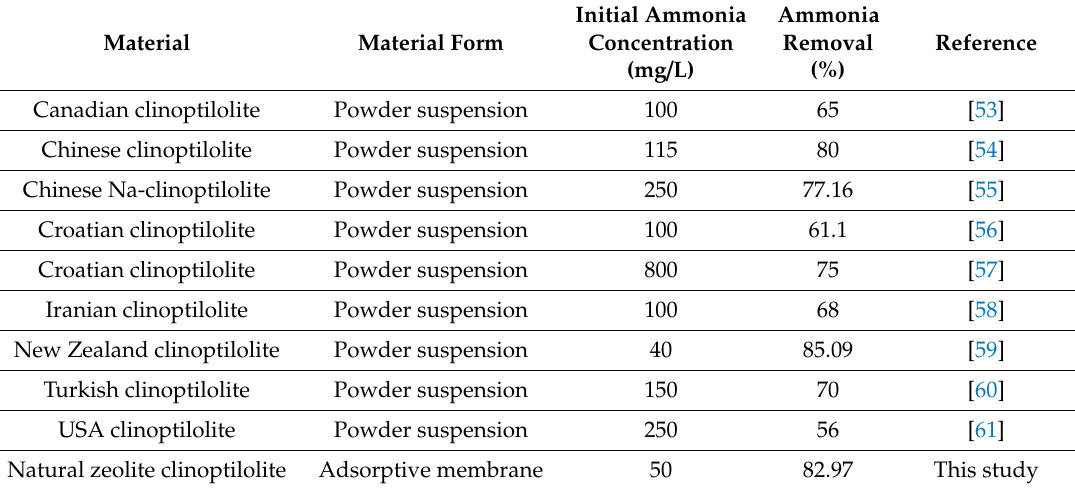
Figure 12. The schematic intraparticle pores of an adsorbent particle in adsorption process [51]. Table 1. Ammonia adsorption by natural zeolite